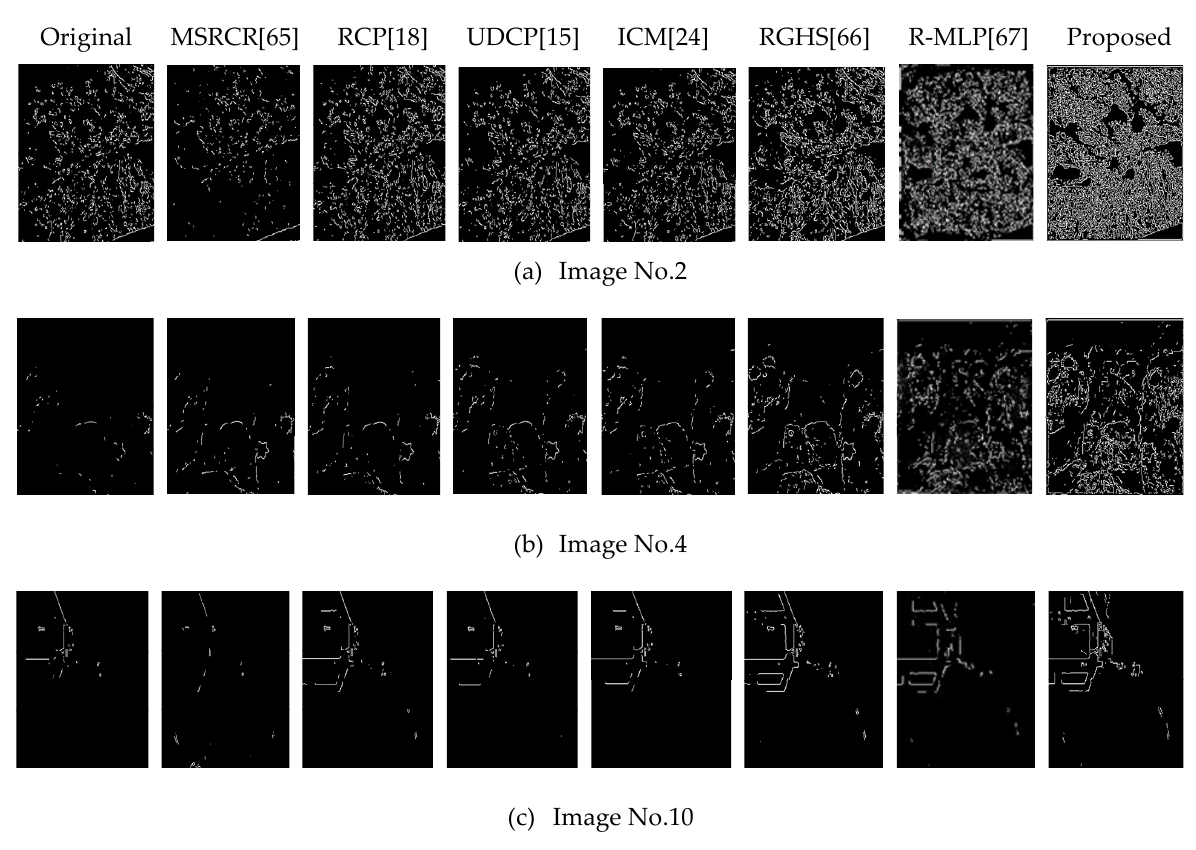
Figure 14. Edge detection [15,18,24,65–67].